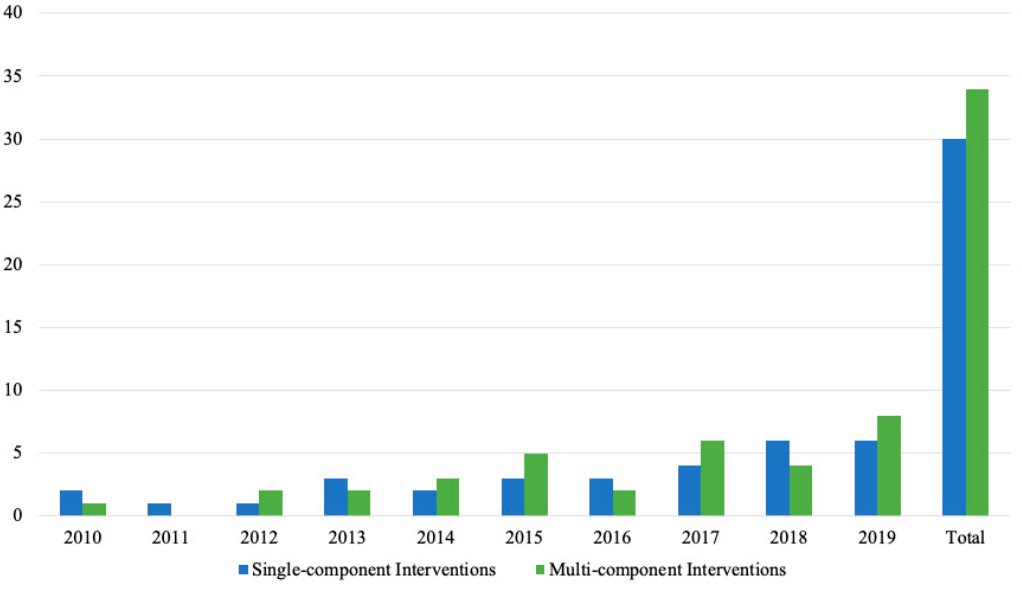
Figure 2. Number of single- and multi-component interventions by year.